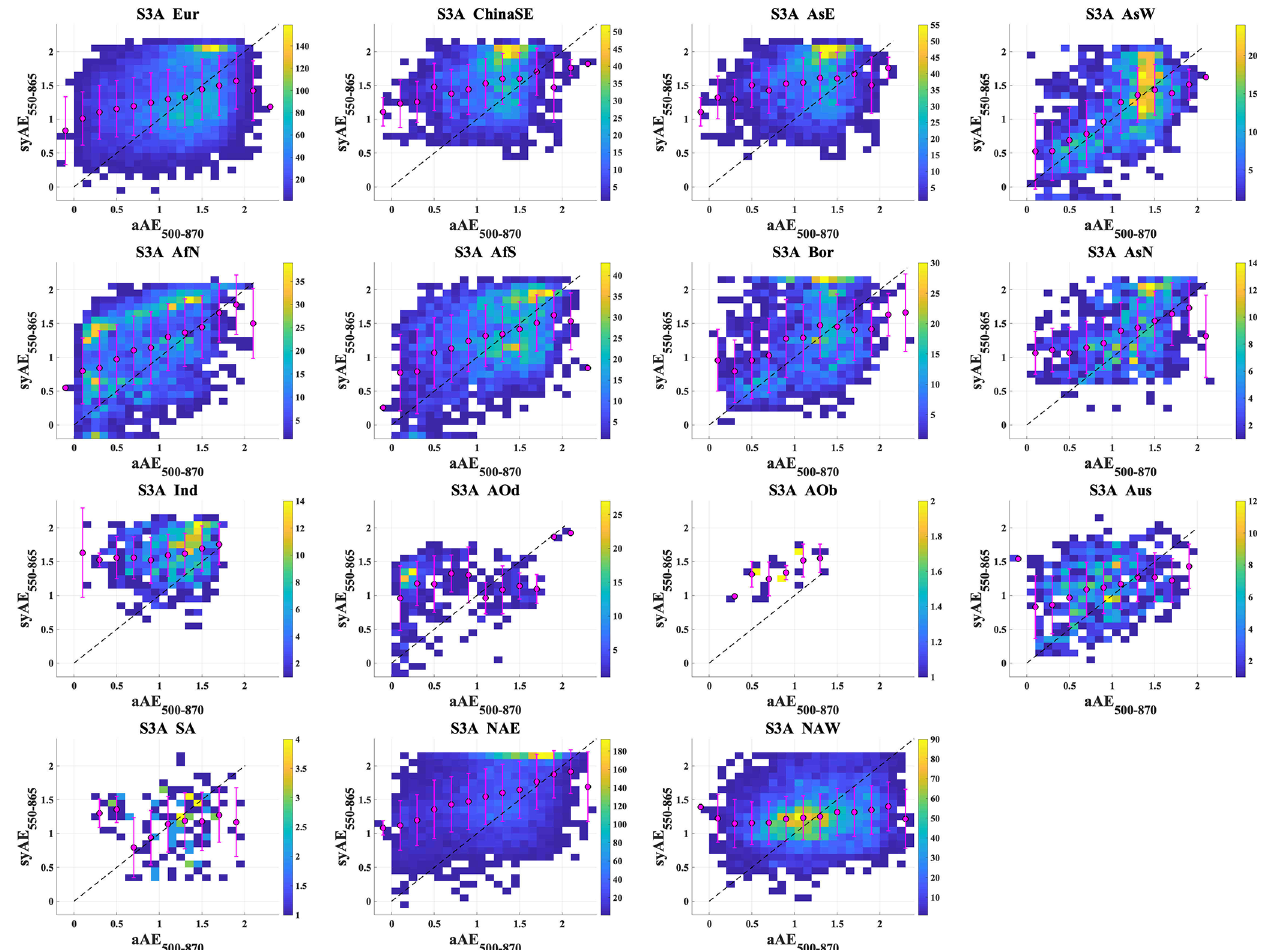
Figure 24. Regional scatter density plots between syAE 550–865 and aAE 500–870 . Regions are defined in Fig. 6.